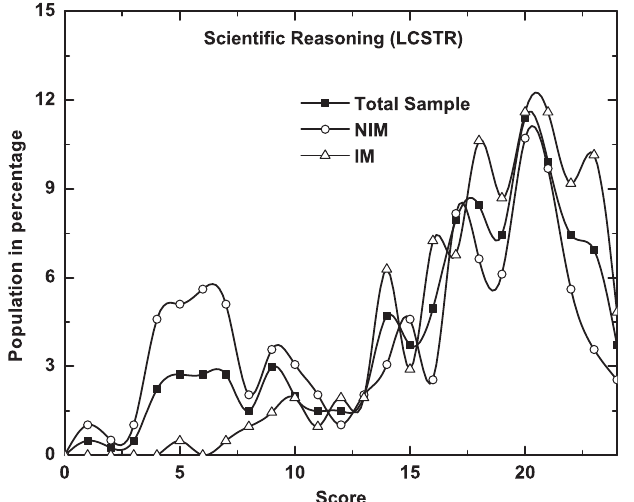
FIG. 3. Performance of Indian students in the LCTSR [23], a standardized test in general scientific reasoning consisting of 24 questions. The graph is first plotted for the whole sample and then separately for the NIM and the IM. Note the absence of